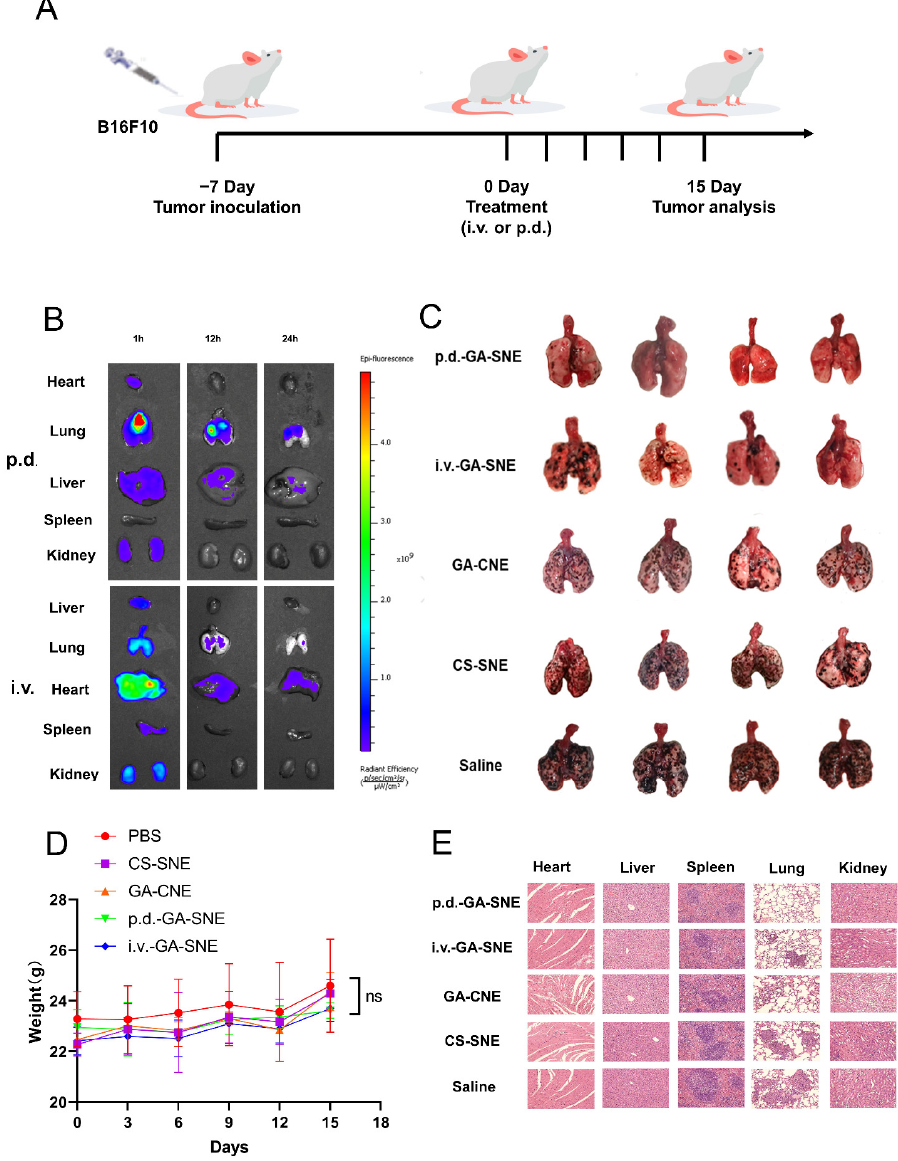
Figure 5. In vivo efficacy of GA-CNE in a murine tumor model. ( A ) Schedules for treatment and analysis. An animal model of lung cancer was created by injecting B16F10 cells (1.5 × 10 6 cells per mouse) into female BALB/c mice (18–20 g). Treatments were administered either by pulmonary de ‐ livery or by tail ‐ vein injection on days 7, 9, 11, and 13 for a total of four doses. Mice were euthanized